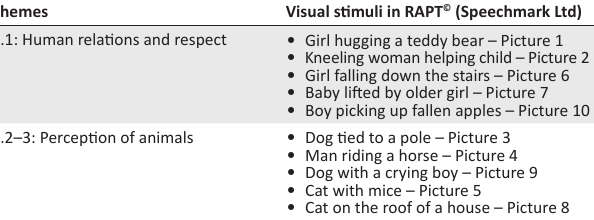
TABLE 2: A table outlining the content of visual stimuli in the Renfrew Action Picture